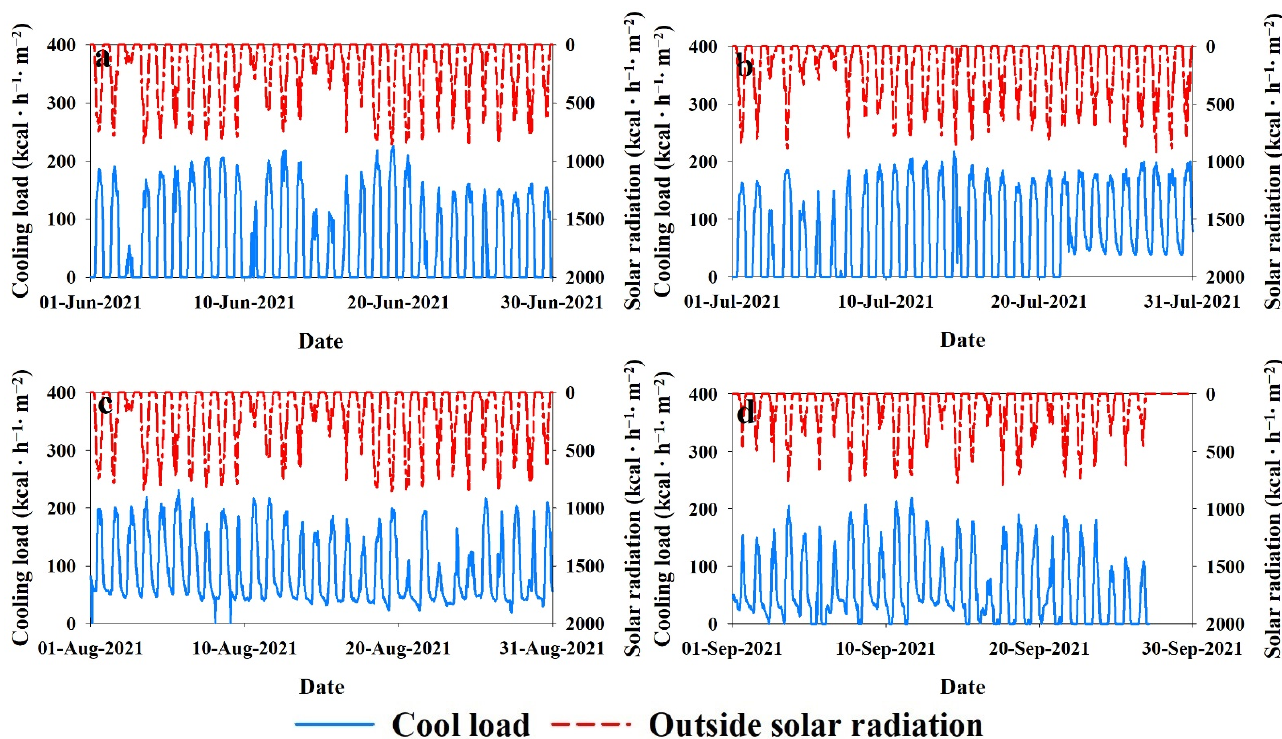
Figure 10. Greenhouse cool load with ambient weather air temperature in ( a ) June, ( b ) July, ( c ) August, and ( d ) September.